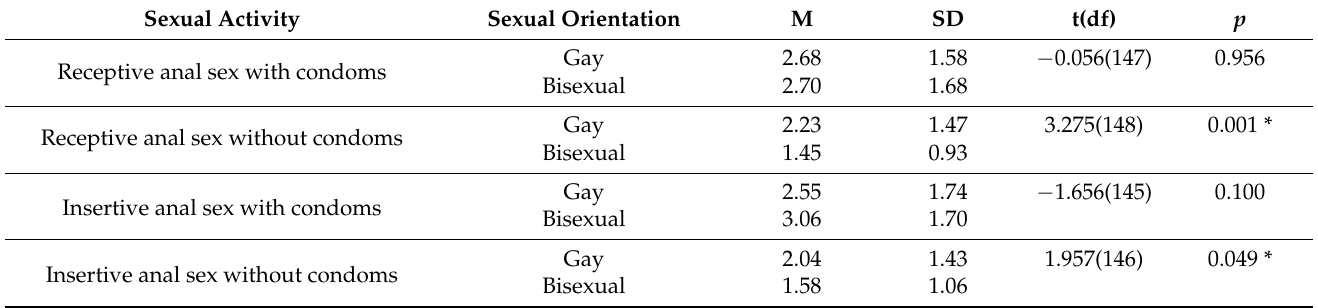
Table 2. Sexual Practices by Sexual